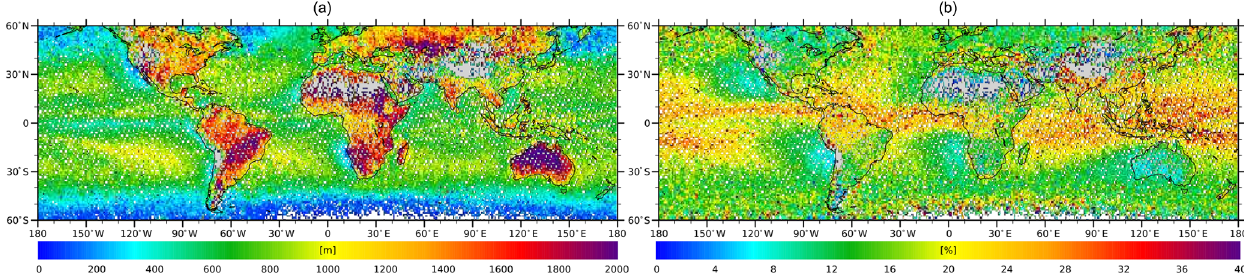
Figure 1. Time-average distributions of daily values for the 2007–2010 period of CALIPSO retrievals as reported in the CCCM dataset for liquid-water clouds for (a) cloud-base altitude (using the retrieval method of Mülmenstädt et al., 2018) and (b) cloud-top height variability.